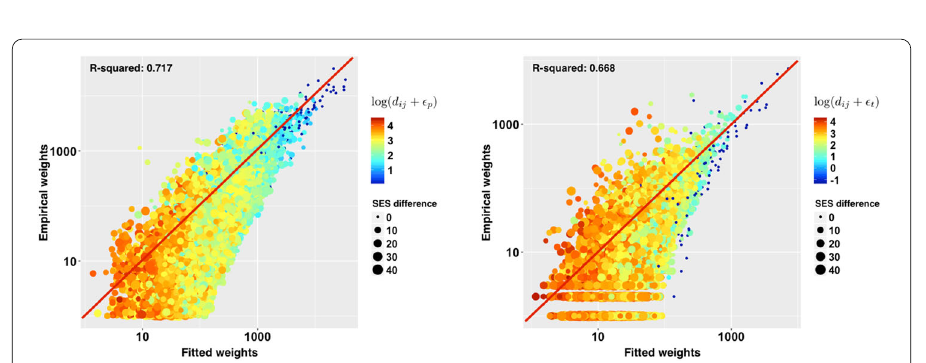
Figure 17 Weighted OLS fitting for (Left) number of purchases and (Right) number of mentions, for the European metropolitan area